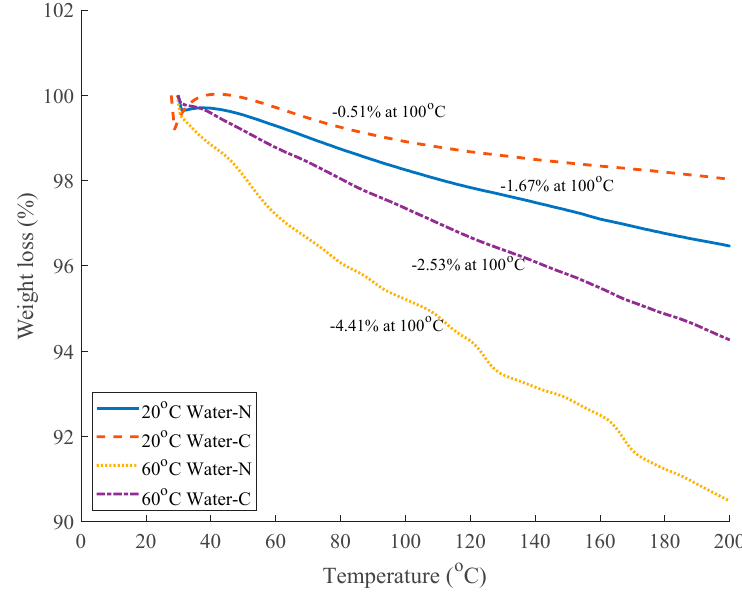
Figure 9. Thermogravimetric analysis of specimens immersed for 135 days.